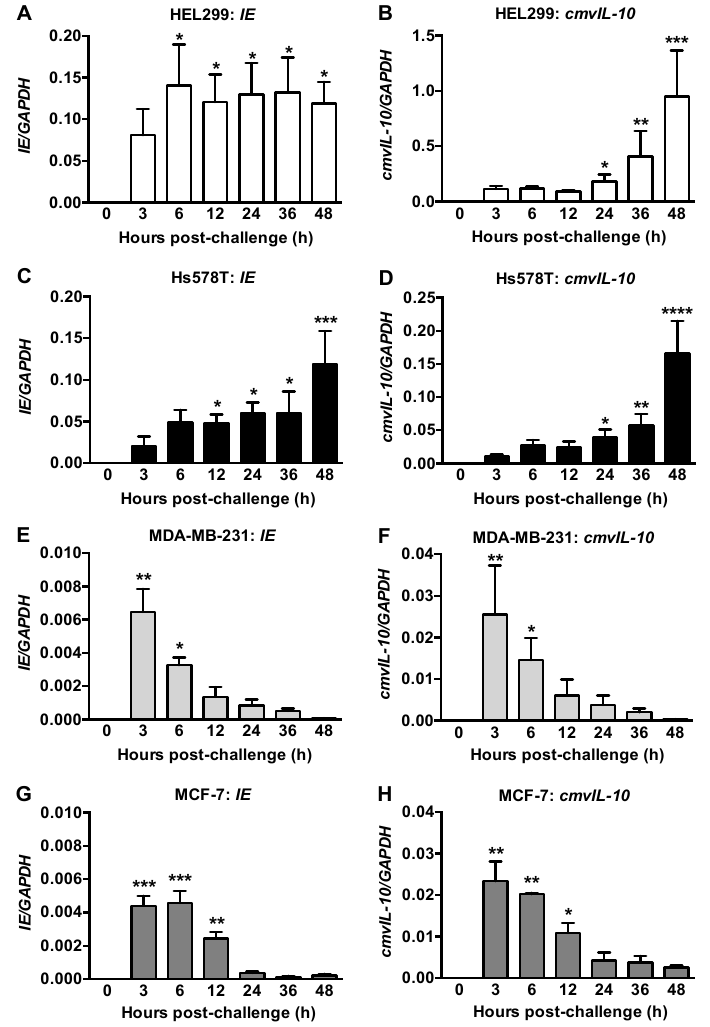
Figure 1. mRNA expression of viral genes in human fibroblasts and breast cancer cells. HEL299 fibroblasts ( A , B ) and Hs578T ( C , D ), MDA-MD-231 ( E , F ) and MCF7 ( G , H ) breast cancer cells were exposed to 1 ( A , B ) or 2 MOI ( C – H ) of HCMV for the times indicated. mRNA of immediate early (IE; A , C , E , G ) and cmvIL-10 ( B , D , F , H ) viral genes were measured and normalized to GAPDH. No expression of viral mRNA was detected at 0 h. Results are mean ± SEM from 3–5 independent exper- iments and p -values were calculated by the Kruskal-Wallis test with a Dunn’s multiple comparisons test. *, p < 0.05; **, p < 0.01; ***, p < 0.001; ****, p < 0.0001. Hs578T, MDA-MB-231 and MCF-7 breast cancer cells were exposed to 2 MOI of HCMV. Expression of IE and cmvIL-10 mRNAs in Hs578T cells was significantly detected at 12 h or 24 h, respectively, and increased at 48 h compared to 0 h (Figure 1C,D).